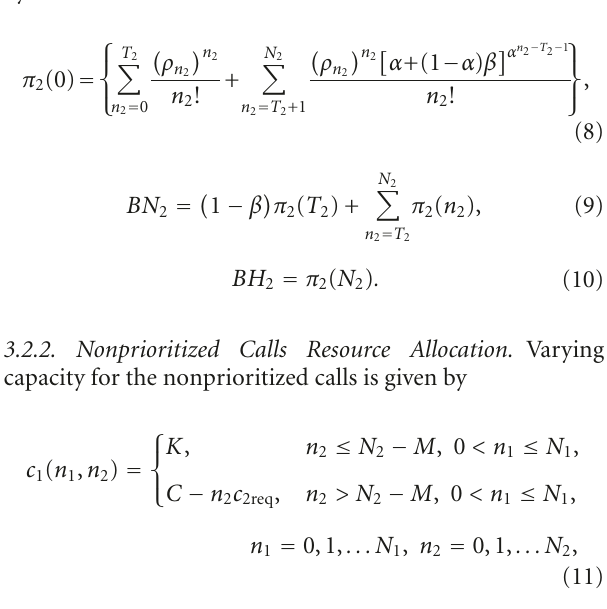
Algorithm 2: Proposed CAC